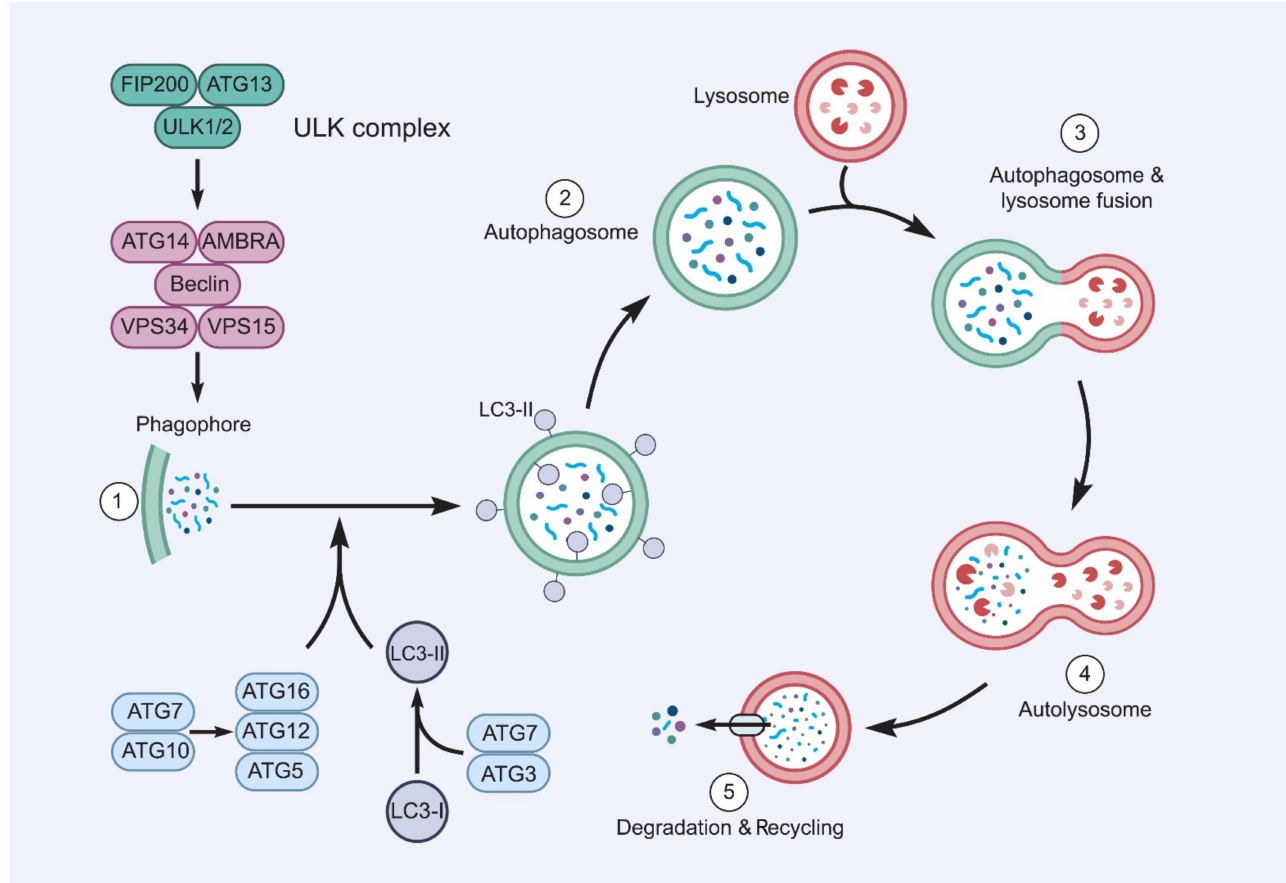
Figure 2. The autophagy processes. Autophagy is triggered by the mechanisms inactivating mTOR, and then autophago- some synthesis participates in the attachment of LC3-II to the membrane of the autophagosome and the production of vesicles that isolate cytoplasmic droplets with their double membrane. Proteolysis, which is the last step of autophagy, requires the fusion of autophagosomes with lysosomes, resulting in the release of degraded content into the cytosol. AMBRA: activating molecule in Beclin1 regulated autophagy; ATGs: autophagy-related genes; LC3-I, II: light chain I, II; VPS: vacuolar protein sorting; ULK1: unc-51-like kinase 1; FIP200: FAK family kinase-interacting protein of 200